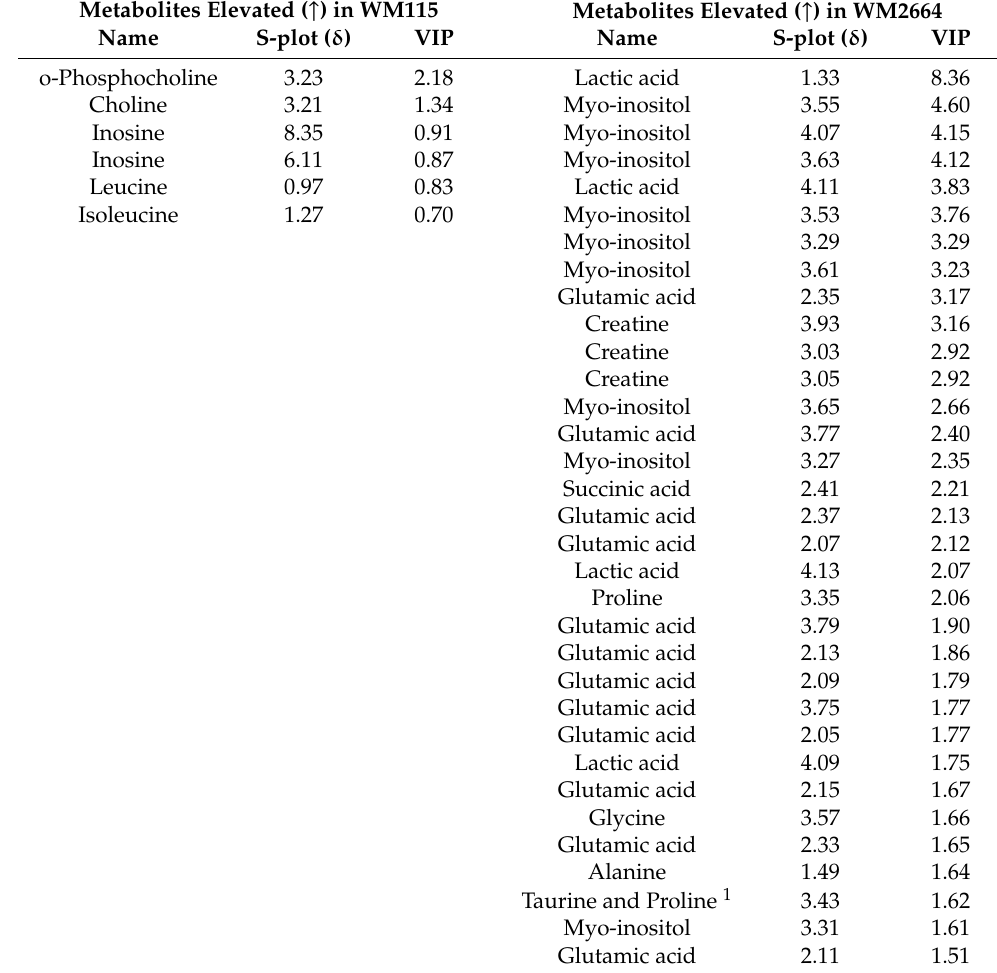
Table 1. Melanoma metabolites selected from S-plot (OPLS-DA model in Pareto scaling), as the most influential in group separation, and their corresponding VIP